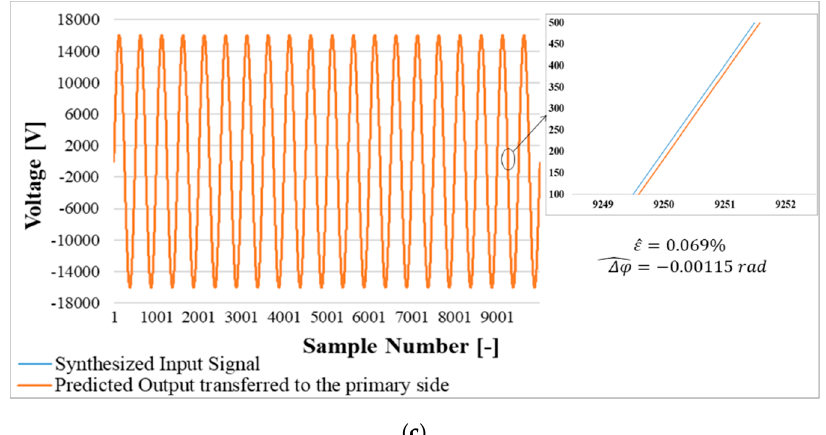
Figure 9. Synthesized sinusoidal input signal and the measured signal prediction by simulation. ( a ) prediction for 50 Hz; ( b ) prediction for 500 Hz; ( c ) prediction for 1 kHz.